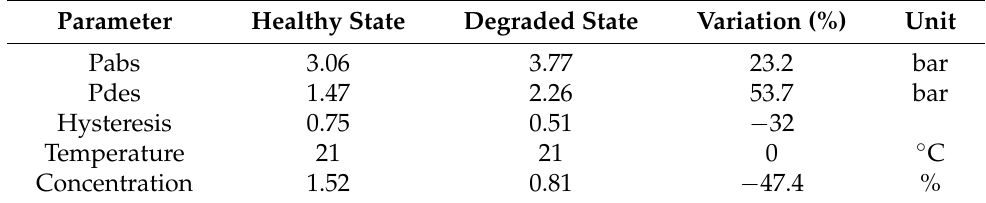
Table 2. A summary of the parameters extracted from Figure 6a,b or Figure